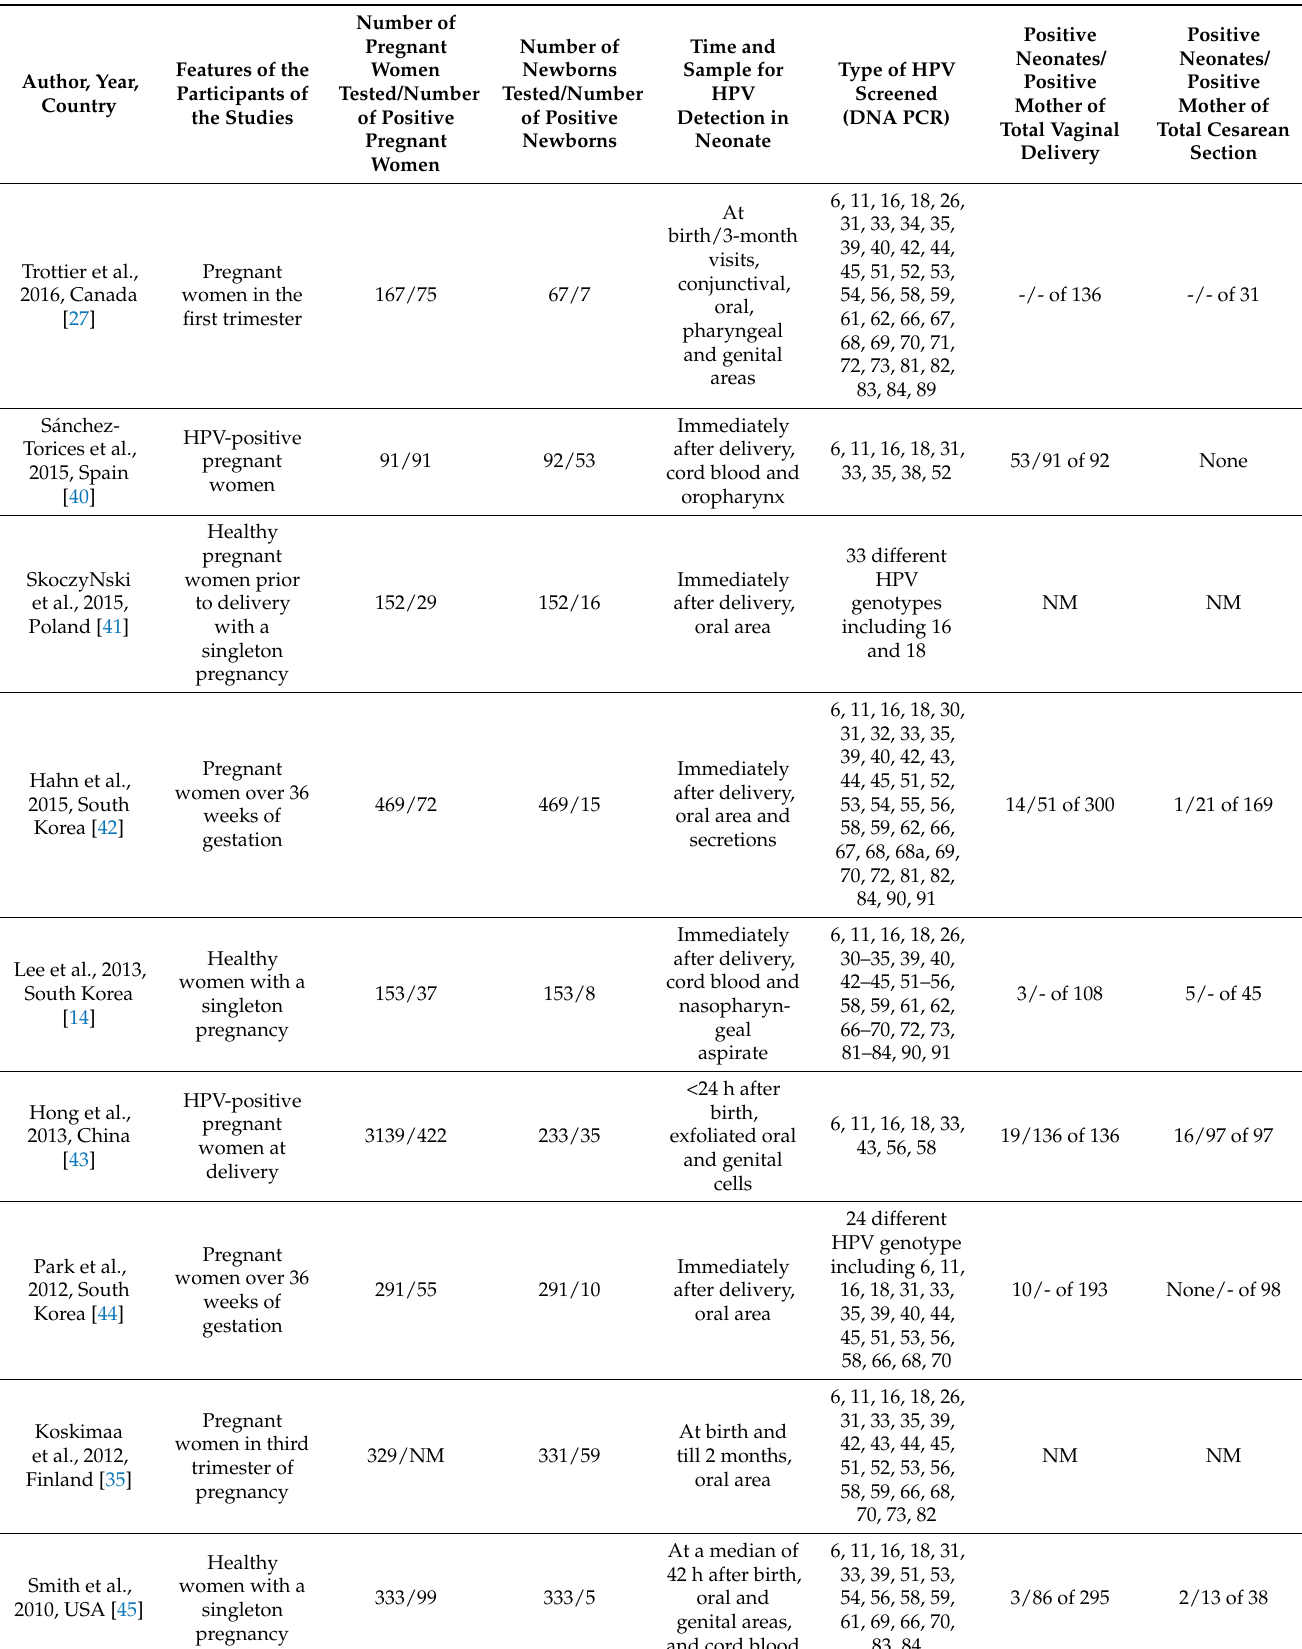
Table 1. Studies regarding maternal–fetal transmission of